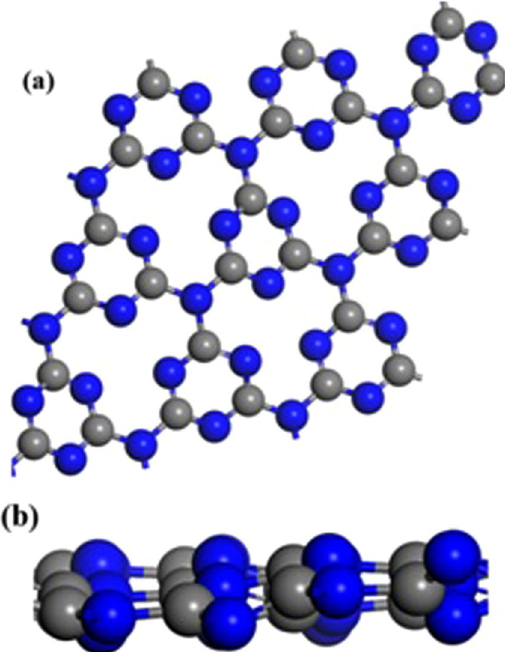
Figure 1. ( a ) Top and ( b ) side view of fully optimized structure of graphitic carbon